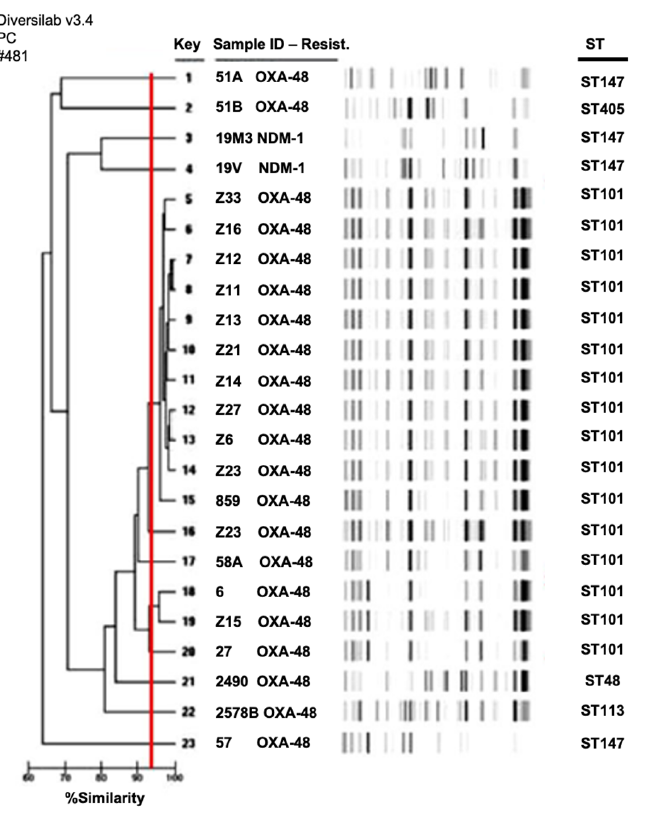
Figure 2. Dendrogram of NDM-1- and OXA-48-producing Escherichia coli isolates. Red line corre- sponds to the limit of the clonality recommended by the manufacturer. 2.5. Plasmid Typing of the Carbapanemase-Producing Enterobacterales The PBRT showed a large diversity of plasmids identified as follows: IncL, Mobc11, IncR, MobQU, colE NT2, FIIK, FV, IncAC, X3, colE NT1, and colE NT2 plasmid type. The different plasmids identified in the CPE isolates are summarized in Table 1.